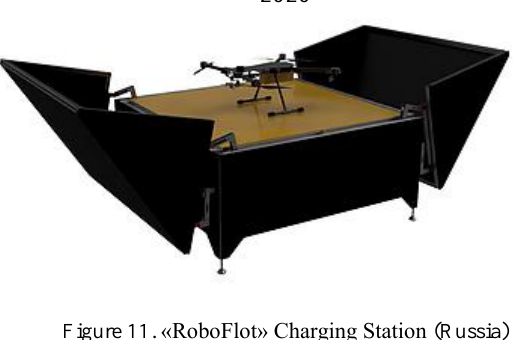
Figure 11. «RoboFlot» Charging Station (Russia) https://www.roboflot.ru/autonomous-copter Last